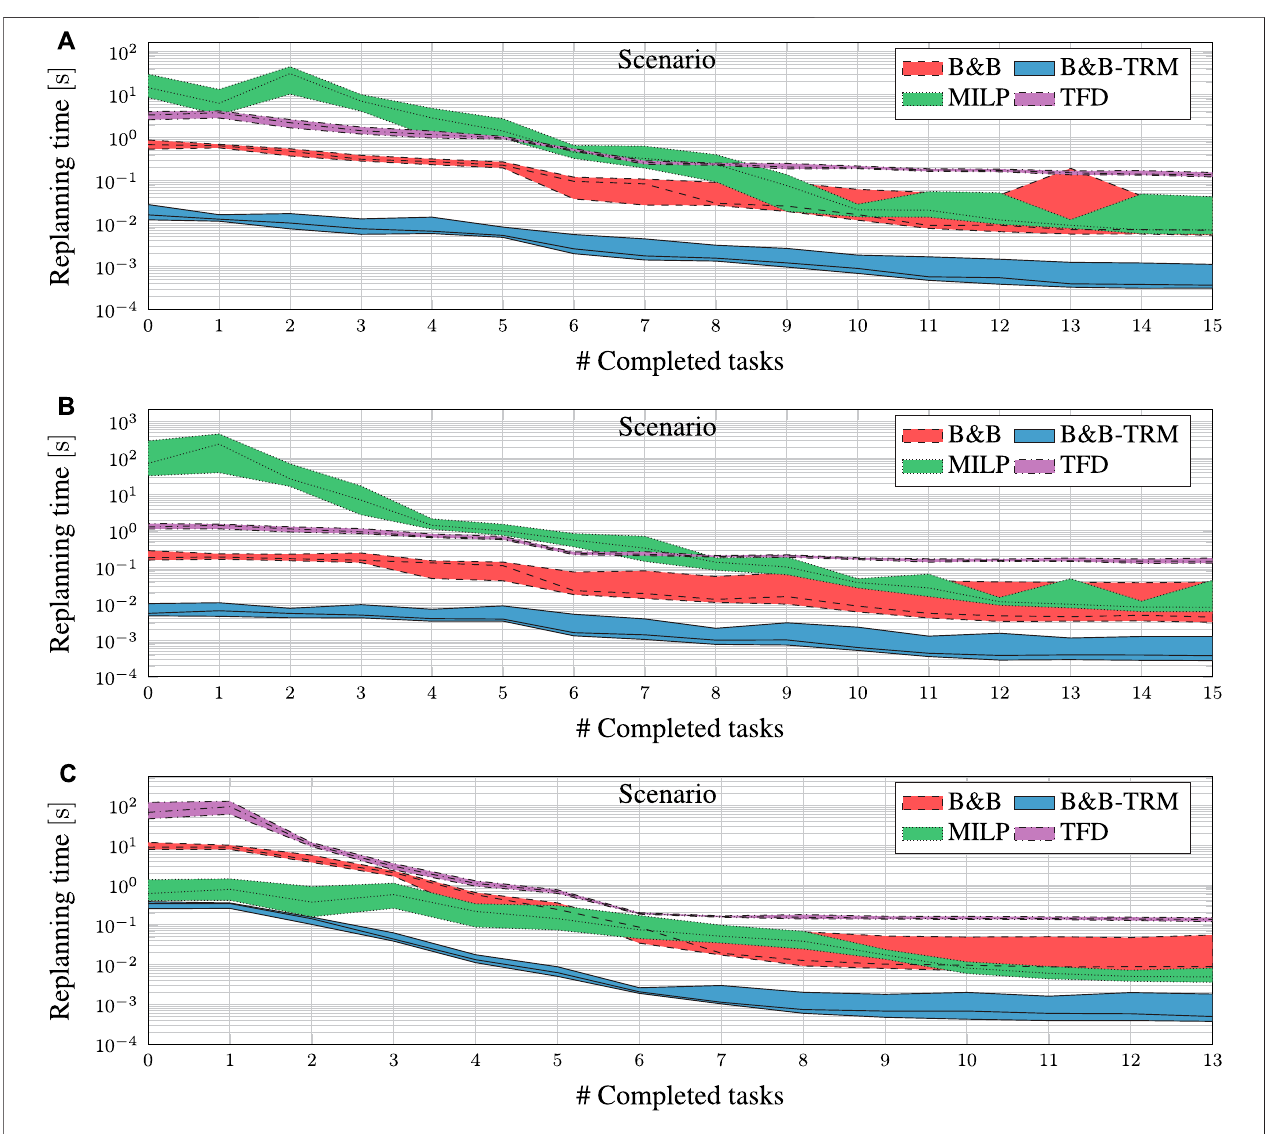
FIGURE 7 | Replanning time for B&B (dashed area), B&B-TRM (solid area) and MILP (dotted area) at different task completion levels. The central line in each area indicates the median. Note that the vertical axis is logarithmic.